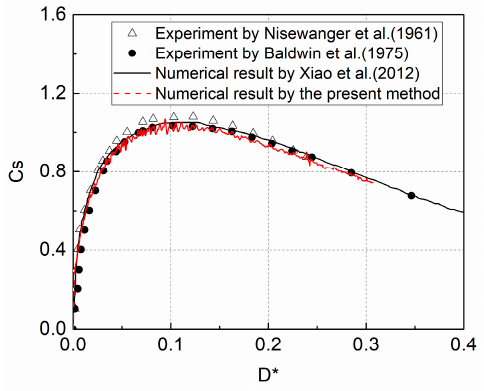
Figure 7. The comparison of non-dimensional impact force between the present method and the previous experimental and numerical